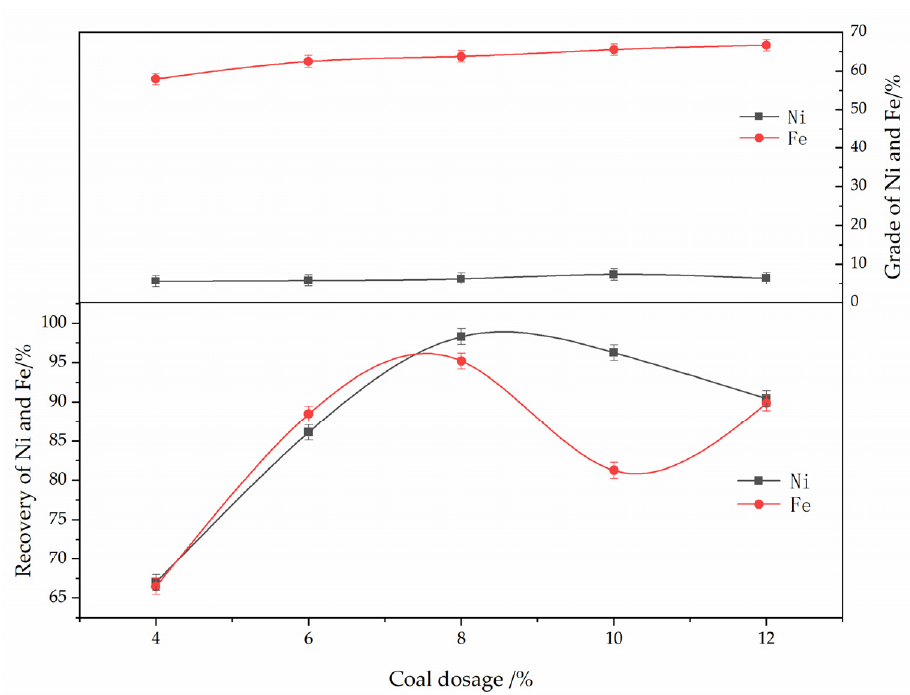
Figure 8. The effect of reductant dosage on the grade and recovery of nickel and iron in ferronickel concentrate. (The ferronickel concentrate dosage was 30 wt.%, The reducing temperature was 1250 °C, the roasting duration was 60 min, the magnetic separation was 150 mT).